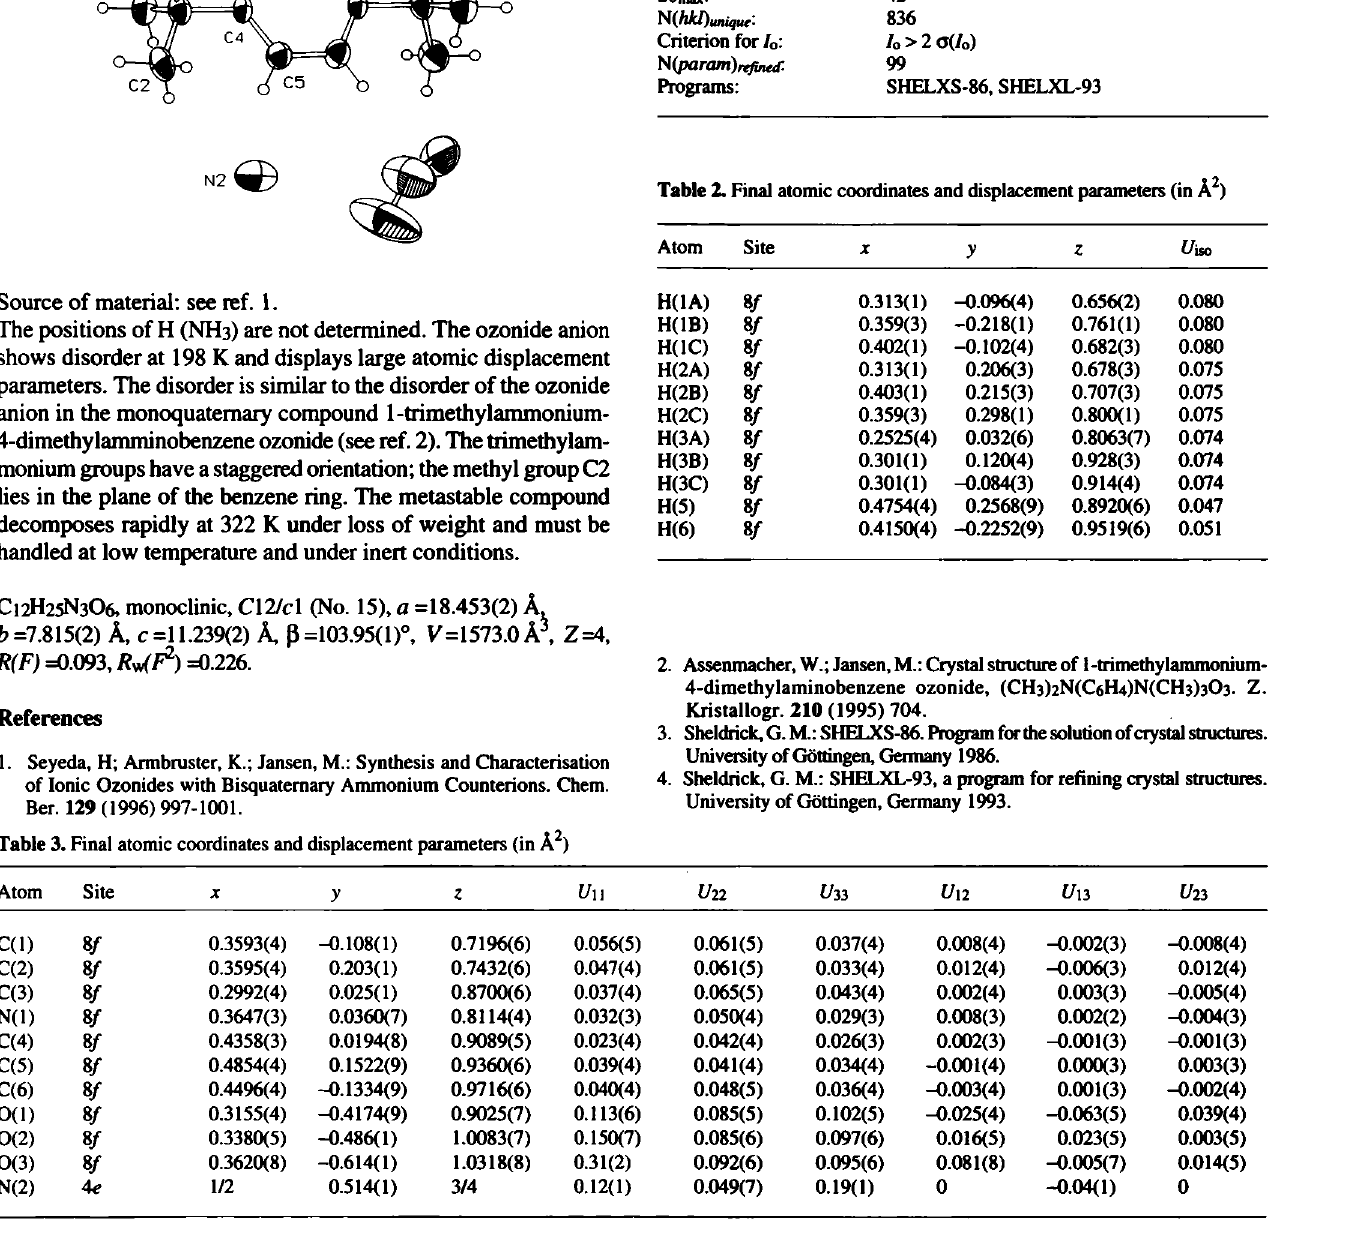
Table 2. Final atomic coordinates and displacement parameters (in Â 2